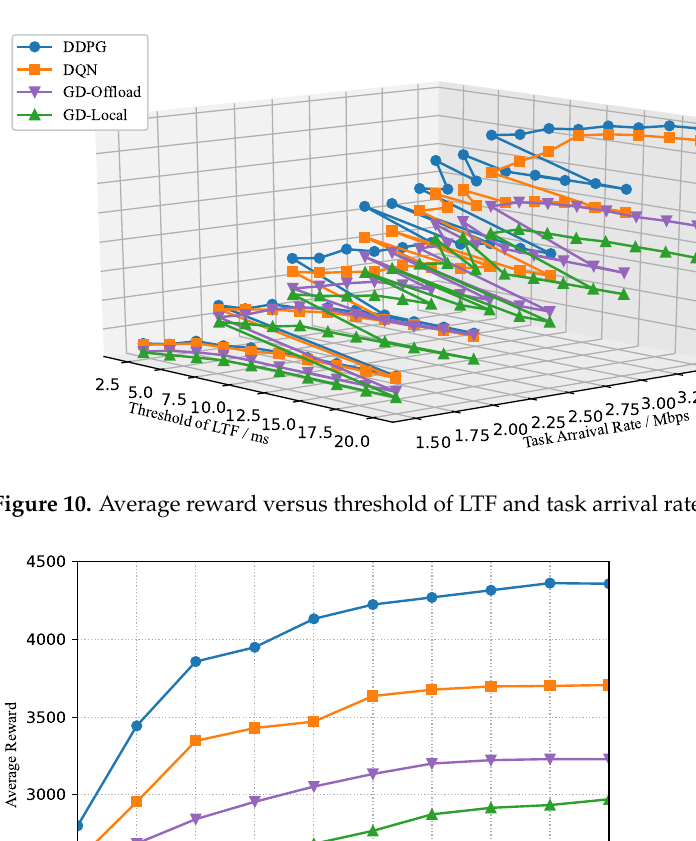
Figure 9. Average block interval versus task arrival rate.